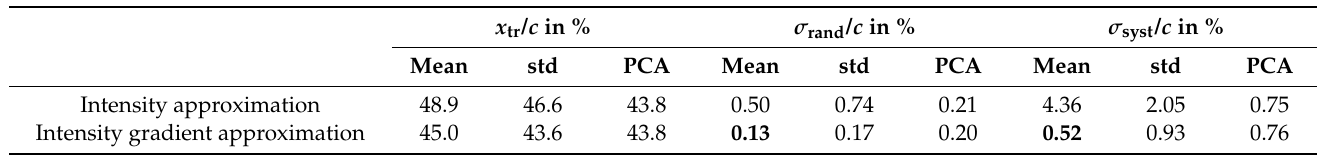
Table 3. Located flow transition position x tr and corresponding random and systematic error σ rand and σ syst by means of both localization methods for each image processing method’s resulting flow visualization from the DU96W180 test case 2 at a Re = 3 × 10 6 . Temporal mean value (mean), temporal standard deviation (std) and PCA. All values are normalized to the chord length c .